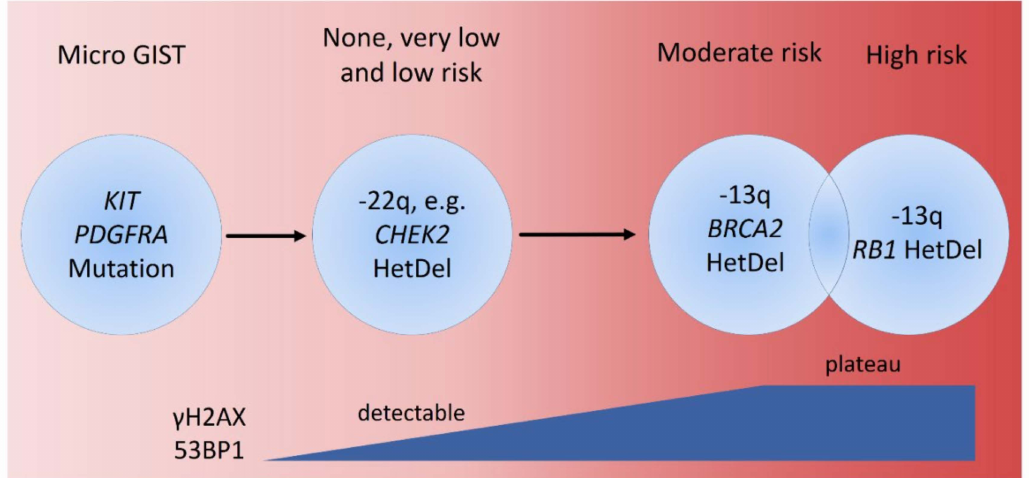
Figure 7. Schematic model diagram illustrates the timing of accumulation of γ -H2AX and 53BP1 in relation to heterozygous deletions of DNA damage repair genes during tumor evolution toward malignancy.